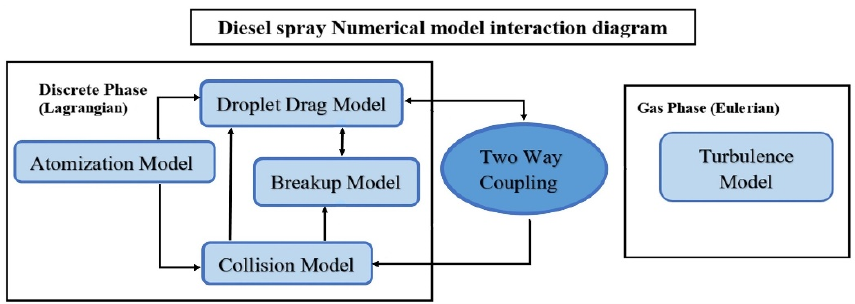
Figure 3. Numerical model interaction diagram for spray simulation.